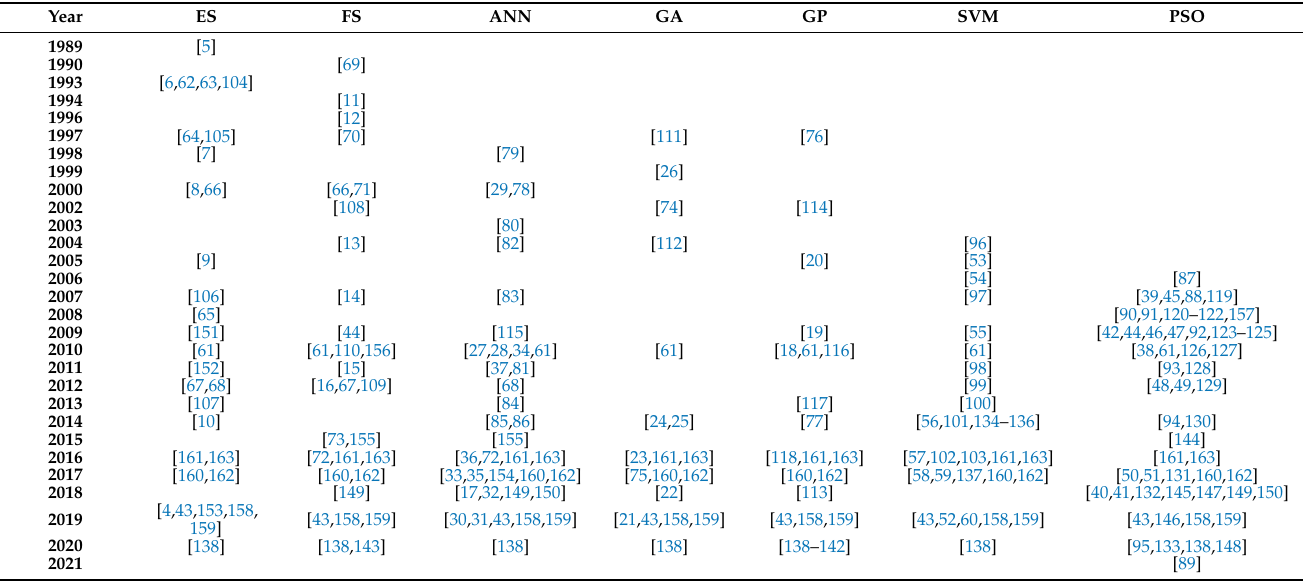
Figure 18. Publishing rate of infrastructure research for each considered AI technique. Table 2. Publications sorted with respect to AI technique and publishing